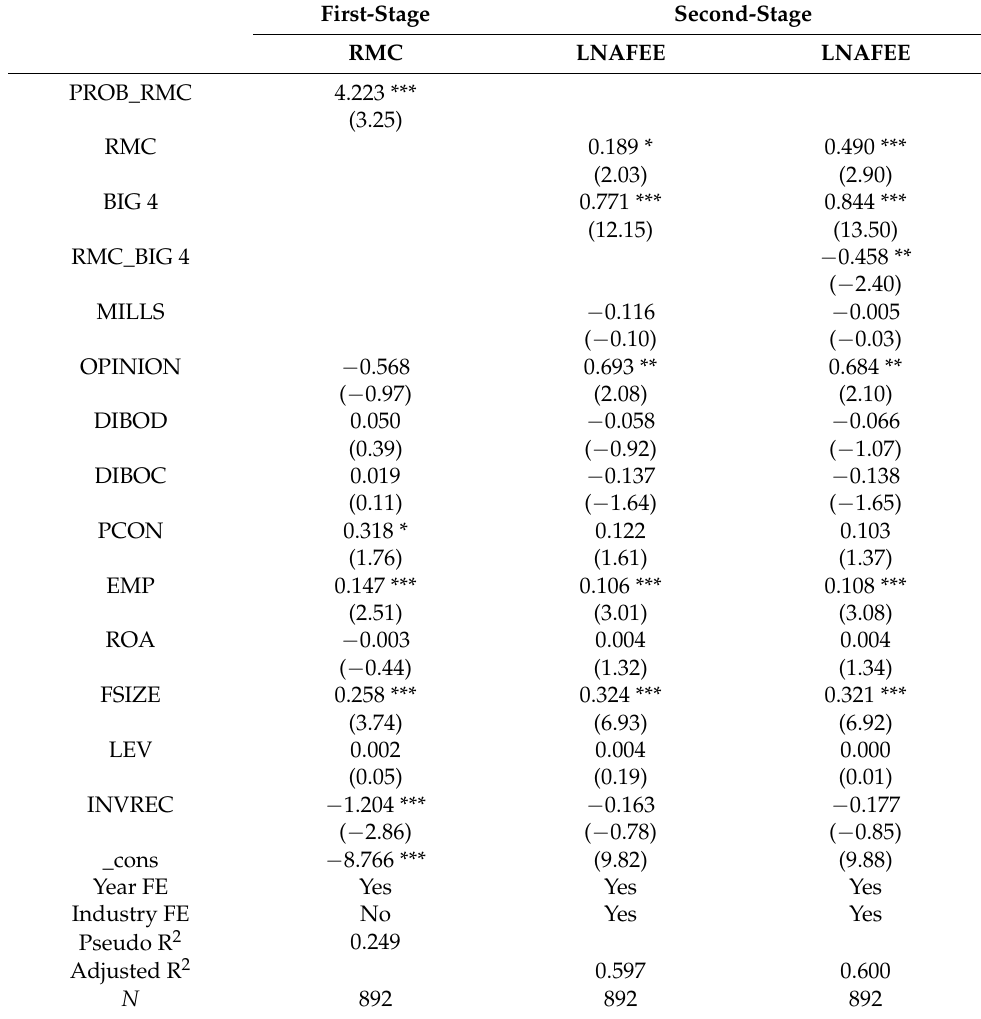
Table 8. Heckman two-stage regression